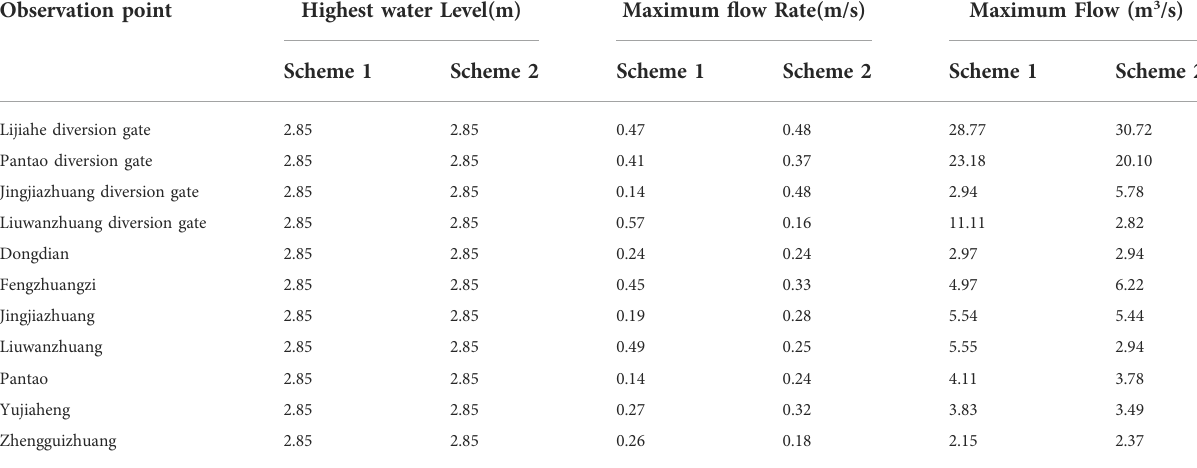
TABLE 2 Hydraulic characteristic data of each observation point of 100-years fl